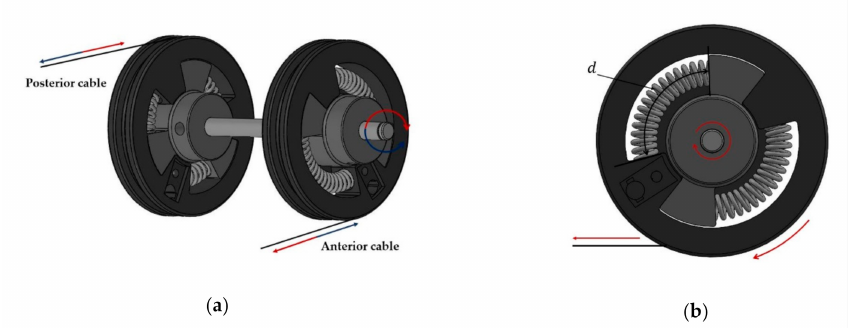
Figure 6. Designed bidirectional tendon-driven actuator (BTDA): ( a ) cable movement direction according to the motor rotation direction; ( b ) pulley connected to the anterior cable. d is the com- pressible spring